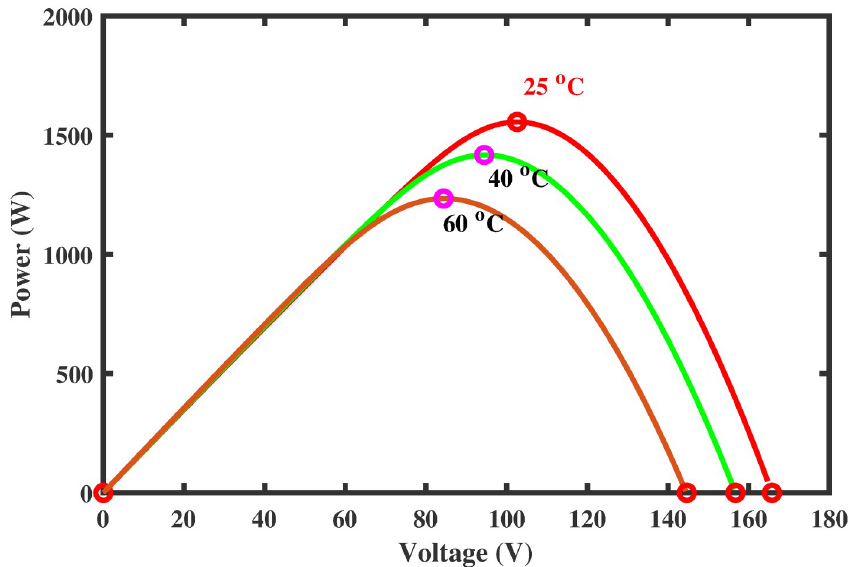
Fig 2. Power characteristic curve under varying